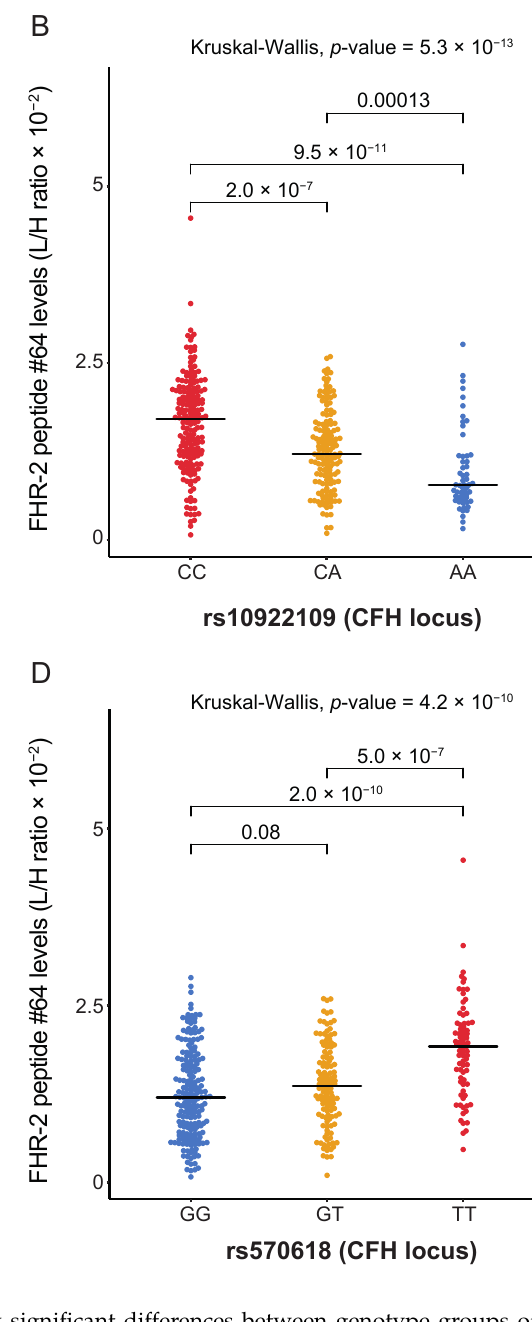
Figure 2. Factor-H related-2 (FHR-2) peptide levels show significant differences between genotype groups of AMD- associated variants at the CFH locus. Red indicates homozygous AMD-risk increasing genotype, while blue shows the homozygous AMD protective genotype and yellow indicates the heterozygous genotype. The Kruskal–Wallis test was included to test if there was a difference between the three genotype groups, where possible. Medians of two genotype groups were compared with the Mann–Whitney-U test. Showing the distribution of peptide levels in light/heavy (L/H) ratio in blood plasma for ( A ) FHR-2 peptide #64 (TGDIVEFVCK), stratified by rs61818925 genotype at the CFH locus; ( B ) FHR-2 peptide #64 (TGDIVEFVCK), stratified by rs10922109 genotype at the CFH locus; ( C ) FHR-2 peptide #64 (TGDIVEFVCK), stratified by rs148553336 genotype at the CFH locus; ( D ) FHR-2 peptide #64 (TGDIVEFVCK), stratified by rs570618 genotype at the CFH locus. Associations of peptides from FH with genetic variants at the CFH locus did not reach significance after FDR correction, but three variants showed suggestive associations with FH peptide levels with a p -value <0.05 prior to FDR correction (Table 3;